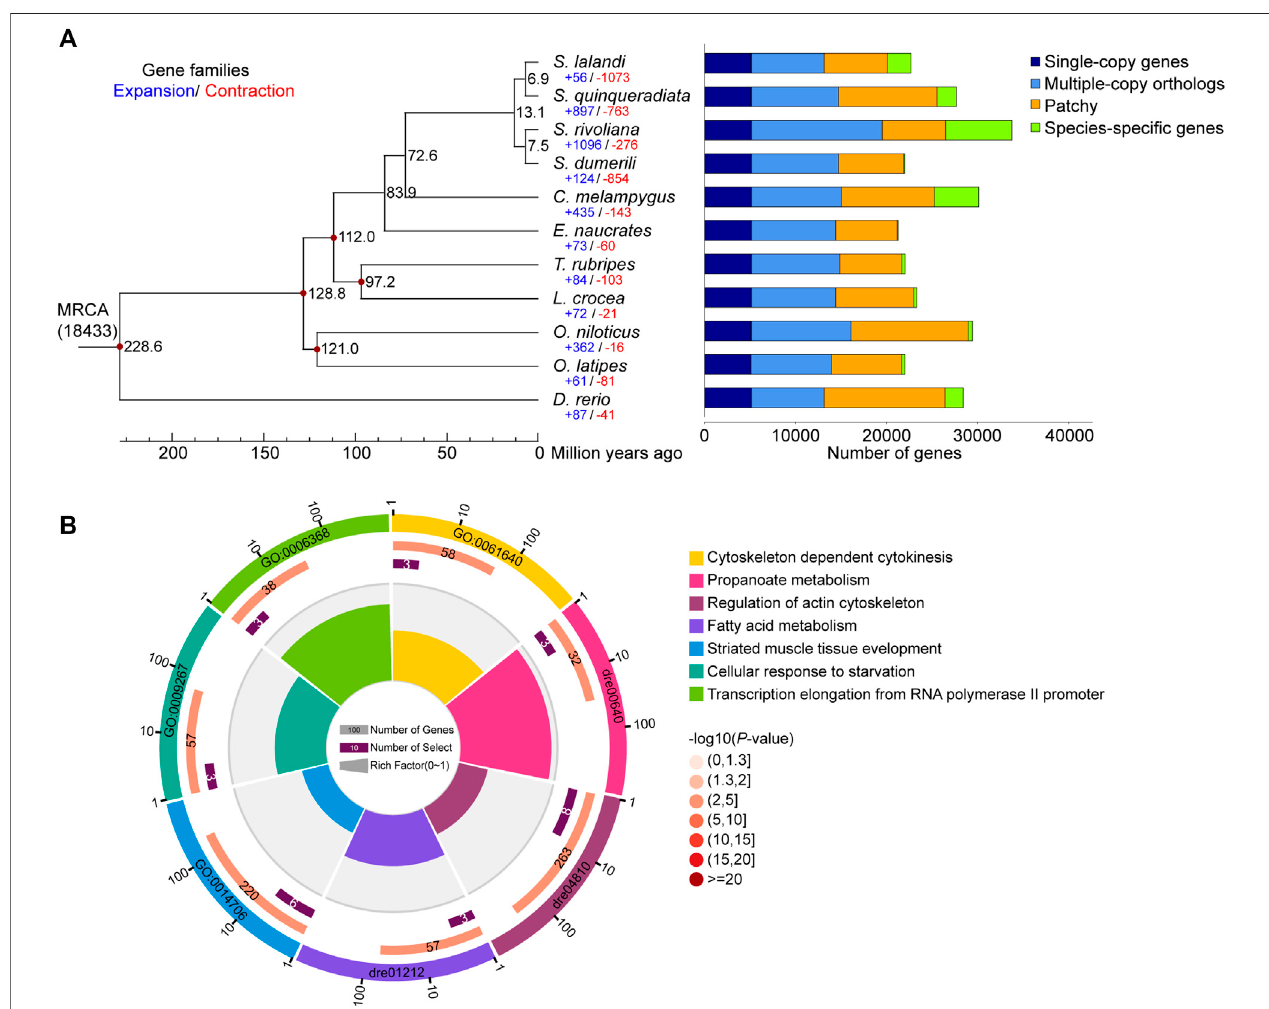
FIGURE 2 | Genome evolution analysis. (A) Phylogenetic tree of 11 teleost genomes, which was constructed using 5,067 single copy orthologous genes. The blacknumbersonthebranchesindicatetheestimateddivergetimesinmillionsofyearsago,andtheblueandrednumbersrepresenttheexpandedandcontractedgene families. The different types of orthologous relationships are shown on the right. (B) The enrichment analysis of 148 positively selected genes detected in S. lalandi genome.